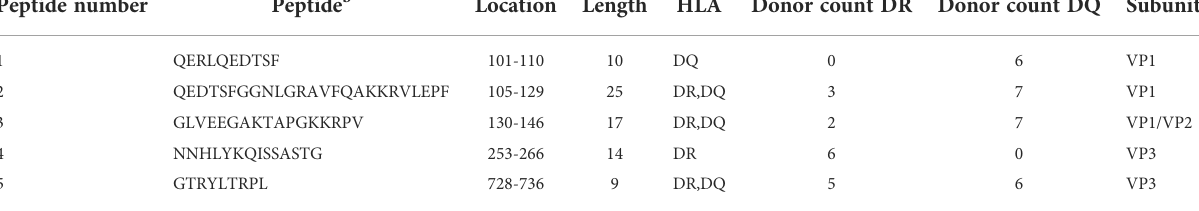
TABLE 3 Promiscuous peptides of AAV6 capsid.